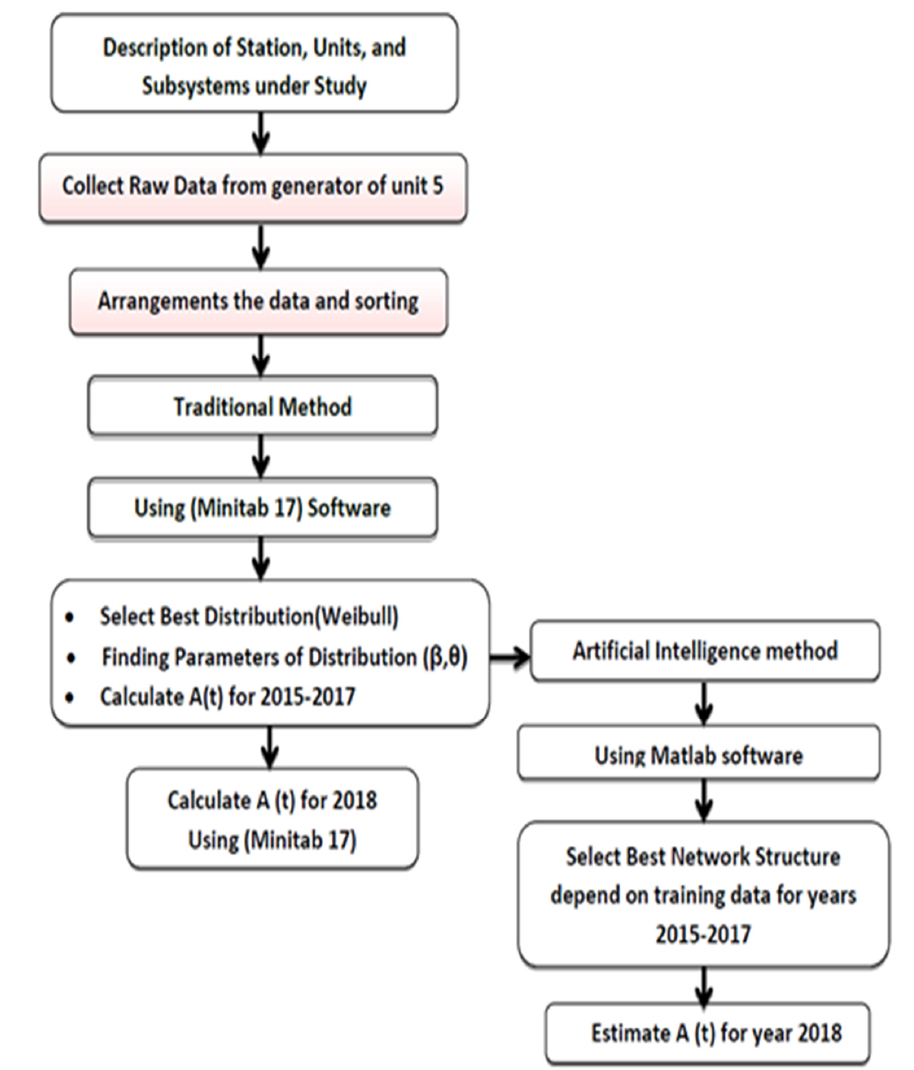
Fig. 3. The Stages and Steps of Proposed Methodology.